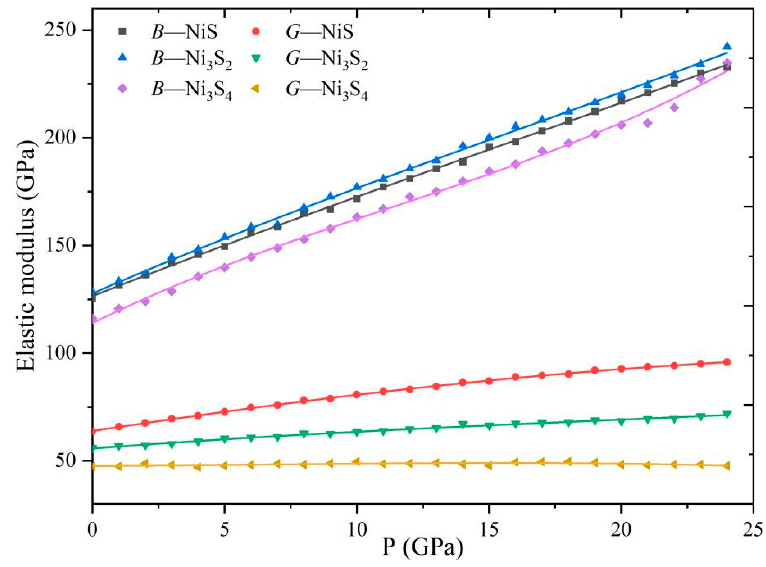
Figure 4. Elastic modulus of millerite, heazlewoodite, and polydymite as a function of pressure.